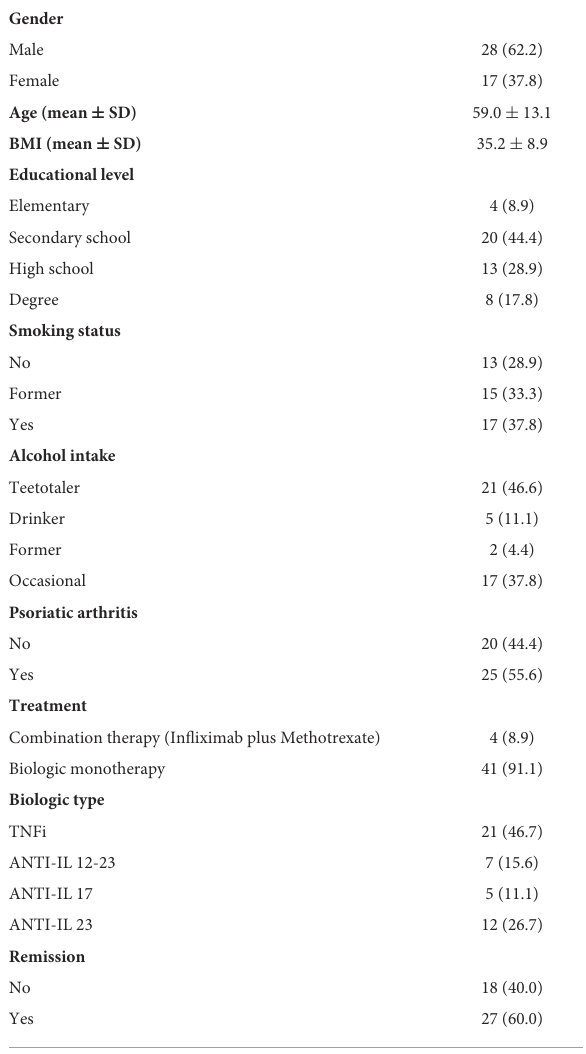
TABLE 1 Baseline characteristics of 45 psoriasis